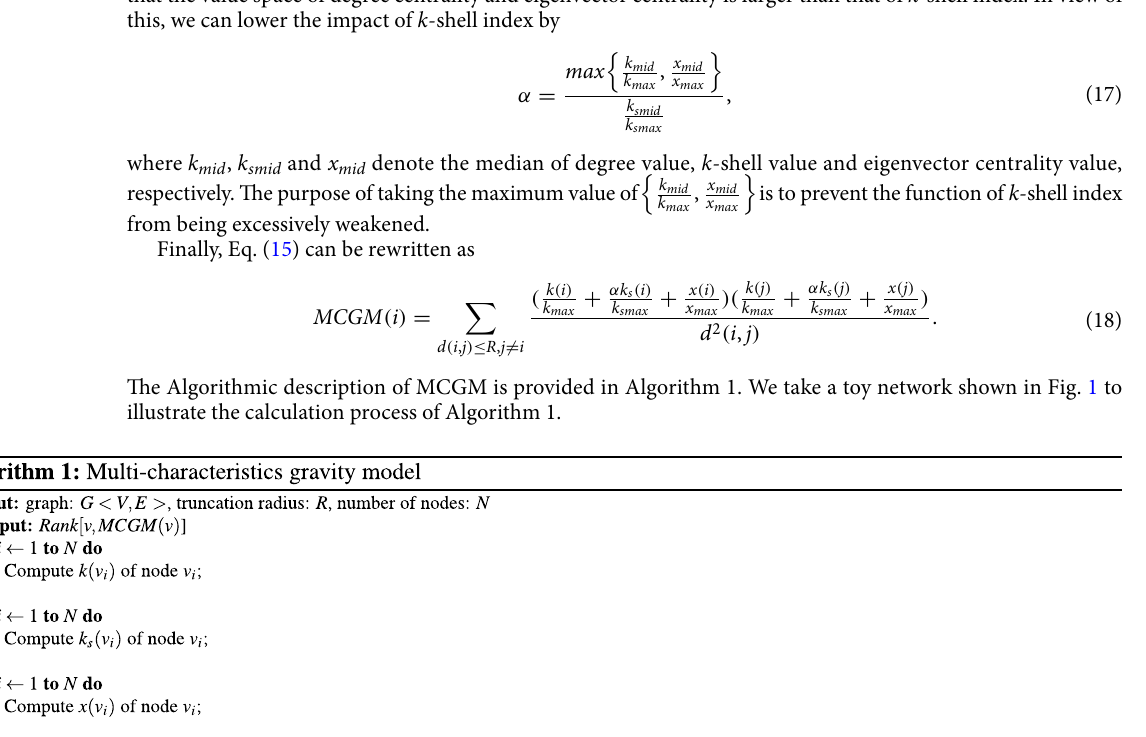
, x mid x max (cid:30) is to prevent the function of k -shell index max